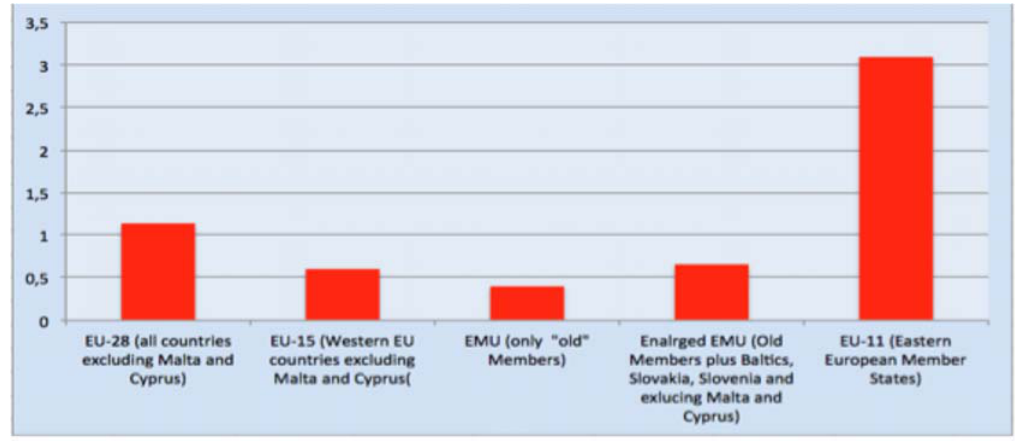
Figure 1 . Average annual regional GDP per capita growth by groups of countries